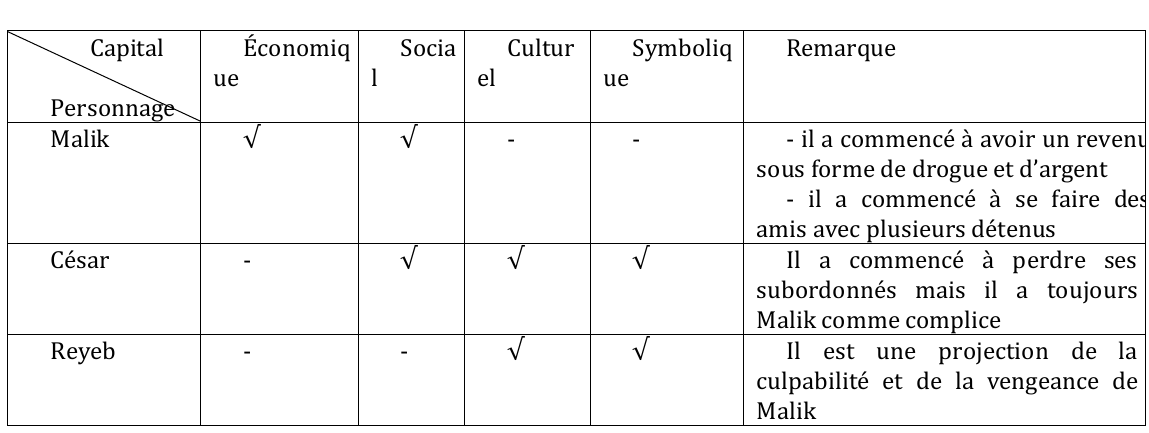
Tableu 2 Le changement des capitaux des